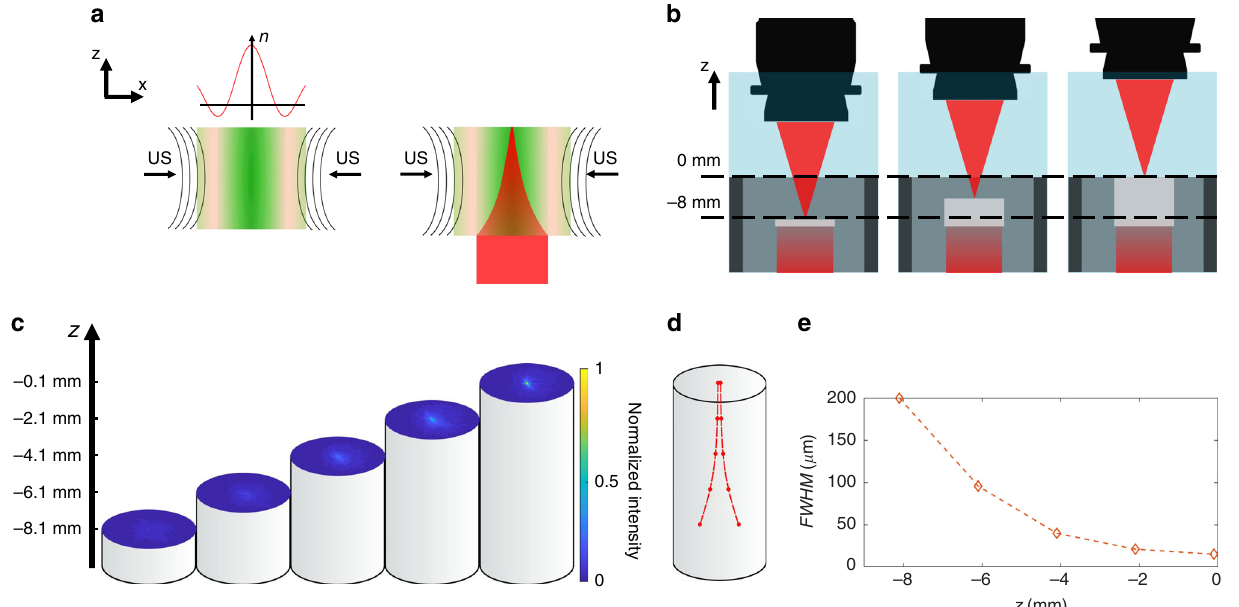
Fig. 4 Gradual beam axial con fi nement. a Ultrasonic waves (US) create a pressure standing wave (green overlay) that modulates the local refractive index of the tissue, sculpting an optical waveguide. b Schematic representation of the experiment, the dashed black lines indicate the highest and lowest location of the top facets of the tissue phantoms. c Experimentally imaged 2D cross-sections of the optical beam pro fi le propagating inside an agar phantom at different heights along the z -axis, showing an effective and gradual con fi nement of light from z = − 8.1 mm to z = − 0.1 mm. d The gradual con fi nement of the beam. In each plane, the dots represent the boundaries of the full width at half maximum of the beam, while the dashed lines show the extrapolated axial trajectory. The intensity has been normalized to the intensity at z = − 0.1 mm case. e Full width at half maximum (FWHM) of the con fi ned optical beam along the axial direction